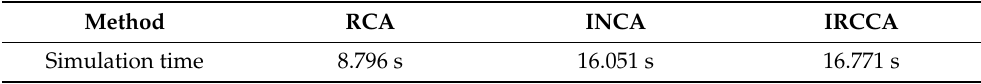
Table 5. The simulation time with no actuator